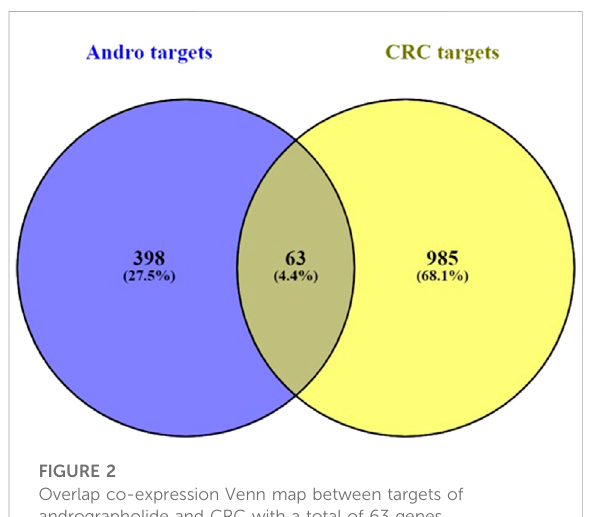
FIGURE 2 Overlap co-expression Venn map between targets of andrographolide and CRC with a total of 63